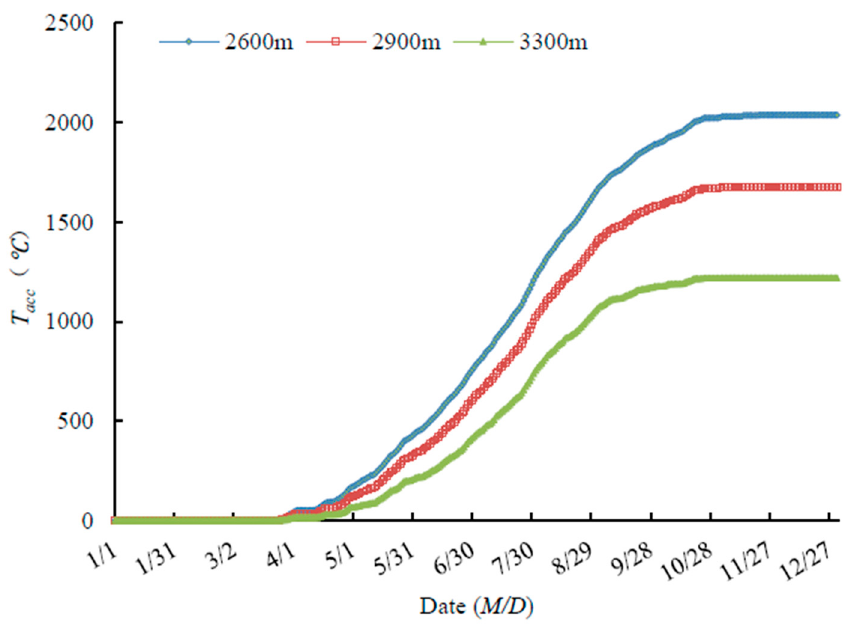
Figure 4. A T acc at different elevations.